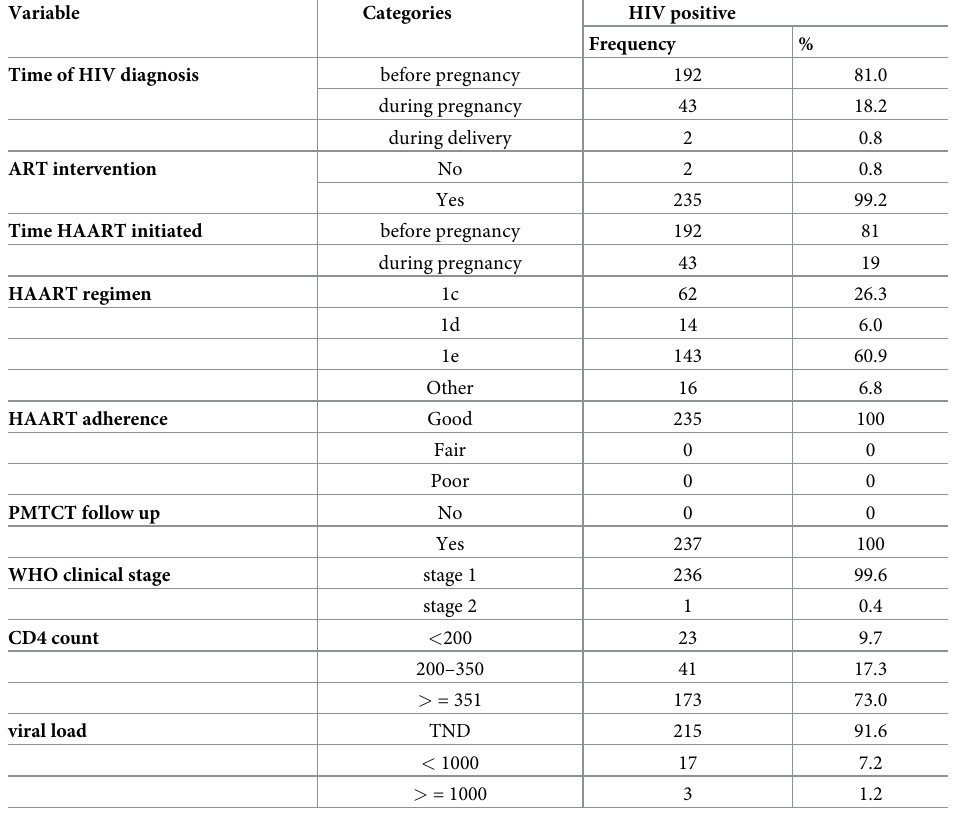
Table 3. HIV related characteristics of the mother delivered in west Amhara regional state referral hospitals N =